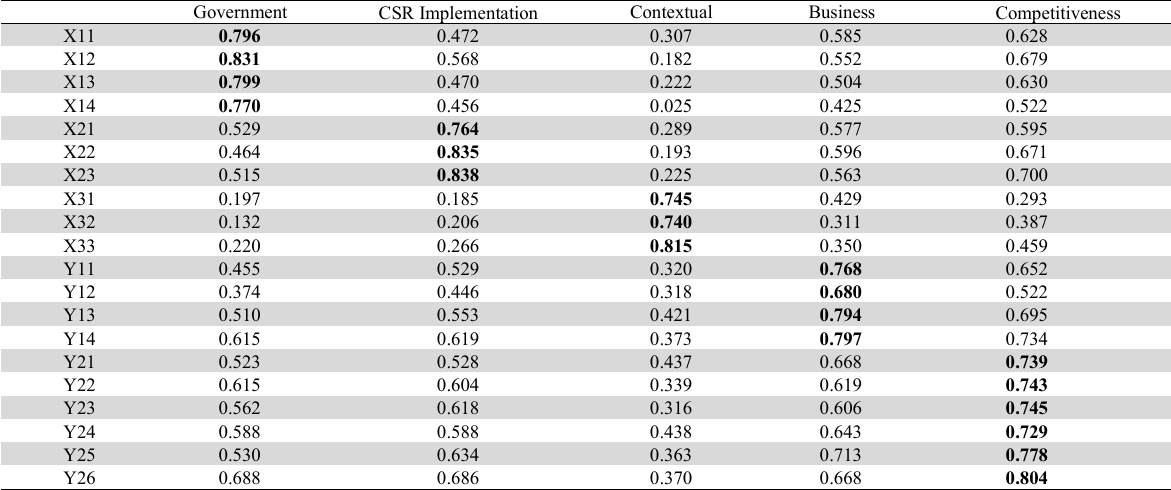
Cross Loading Variables